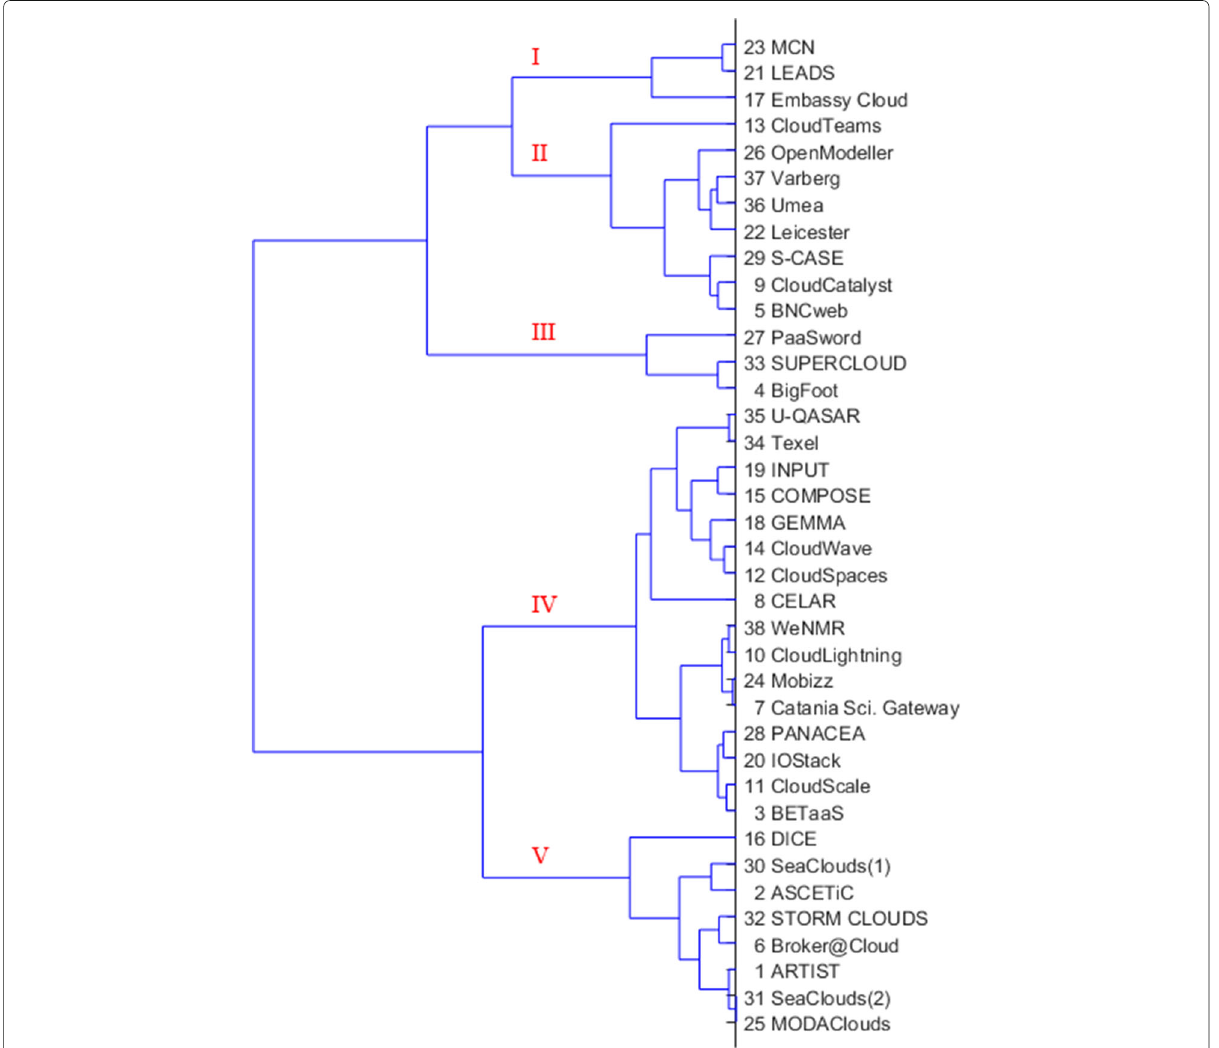
Fig. 7 Cluster tree of cases in the 2-dimensional representation of the decomposition of the 5-dimensional partitioned dataset for the essential characteristics. Ward’s agglomerative hierarchical method was used to form the clusters. Numbered groups are referred to in the “Discussion” section